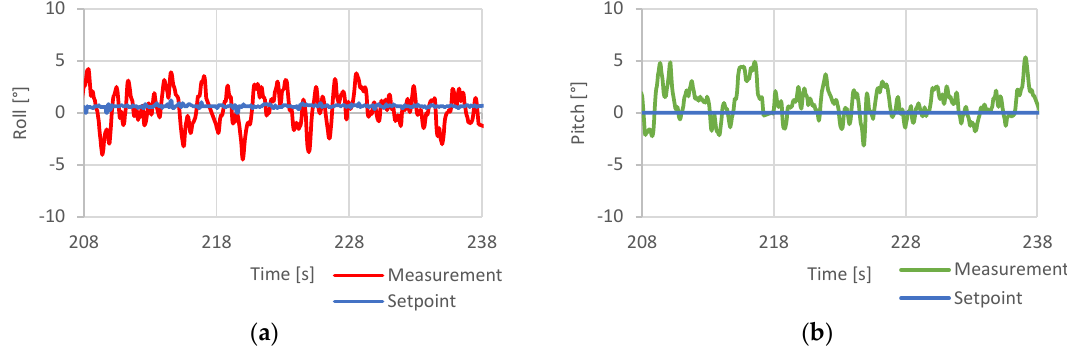
Figure 24. Hover stability test results, ( a ) — roll axis response, ( b ) — pitch axis response [5].